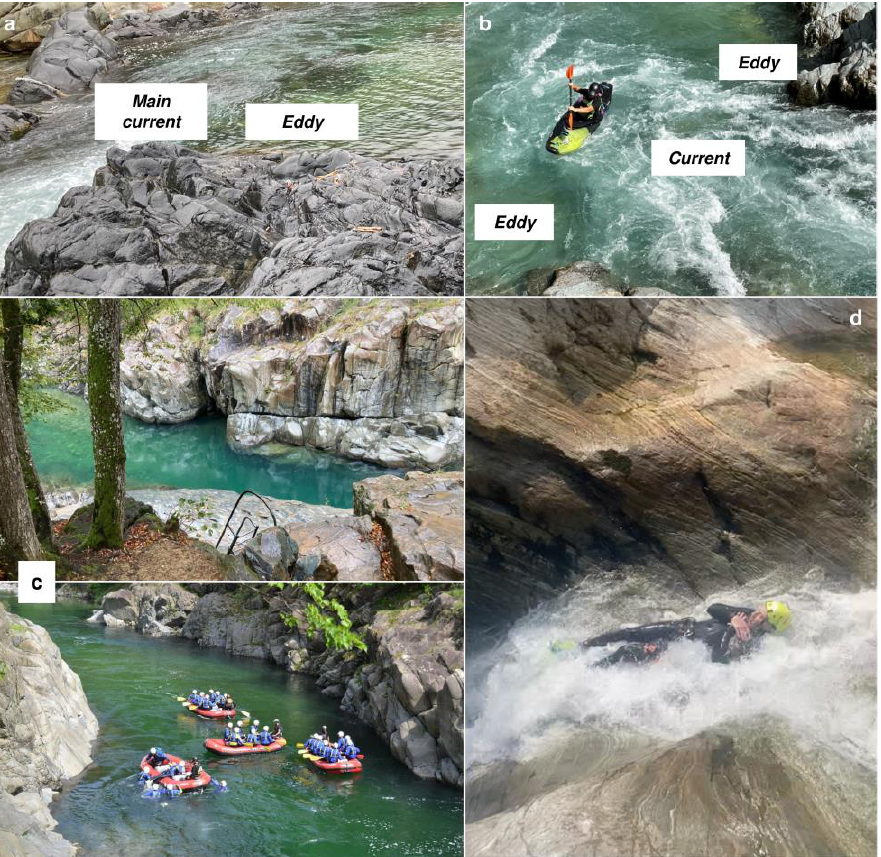
Figure 14. Examples of long-time carved morphologies along Classico del Sesia (CS) and Gole del Sesia (GS). ( a ) CS-M-AI, the rapid of IV degree WW, named Trancia; ( b ) GS-M-AM, the rapid of IV degree; ( c ) CS-M-AA, the gorge carved in peridotite near Balmuccia; ( d ) CNS-M-D, the toboga carved in the Gneiss Minuti Unit along the Canyoning Sorba. The codes are reported in Supplementary S1. Copyright of pictures: GS-M-AM, courtesy of M. Depicolzuane; CS-M-AA, right, courtesy of P. Arcostanzo. See location in Figure 8. For abbreviations, please see Section 3.1.